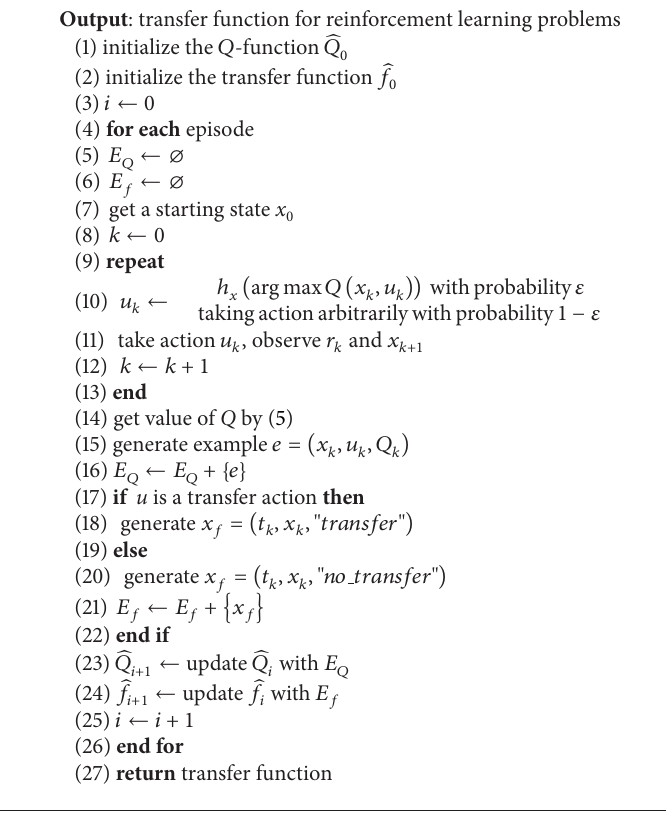
Algorithm 1: Transfer function